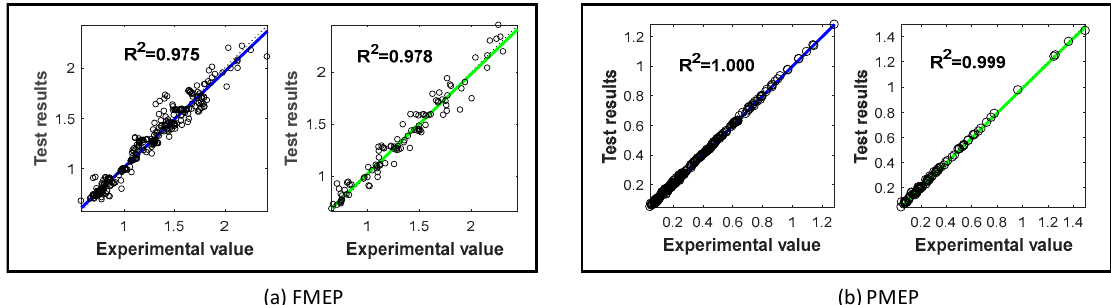
Figure A9. ( a , b ) Comparison of the experimental and ANN fitting results for the physics-based model parameters (BMEP simulation).